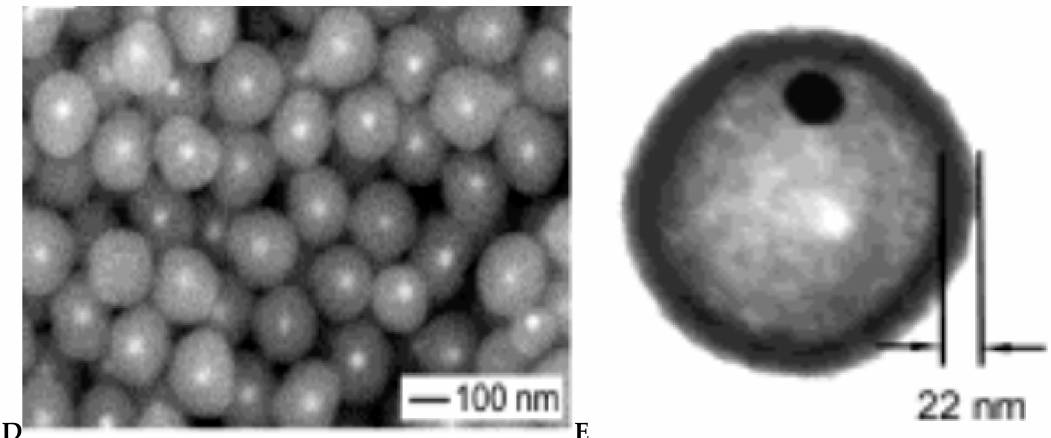
Figure 7. The hollow beads of PBzMA containing moving Au cores ( C ), the SEM image before HF andching ( D ) et the HF etching ( E ) image after HF and PBzMA particles, synthesized routes for Au@SiO 2 @PBzMA NP ( A , B ). ACS, 2003, replicated by reference permission